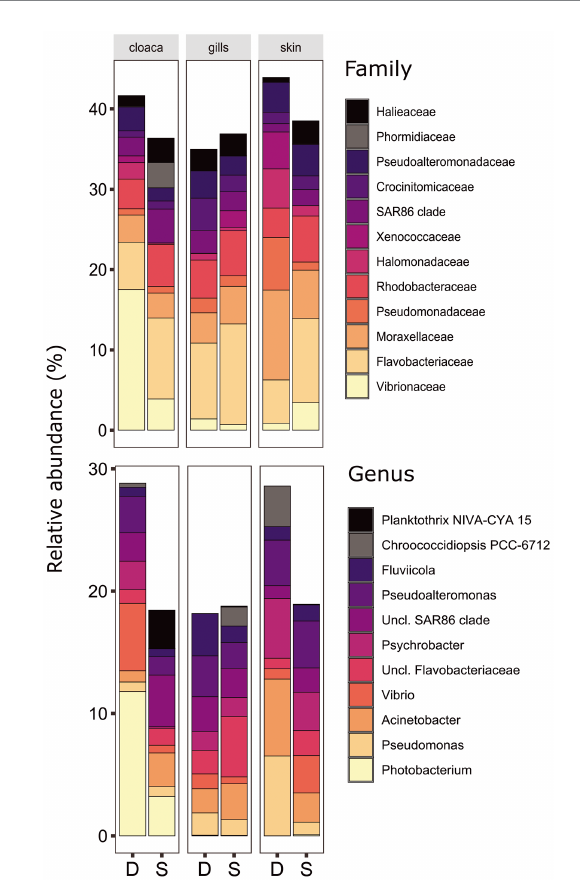
FIGURE 2 Bacterial compositions and relative abundance to Family (top) and Genera (bottom) resolution of dusky (D) and sandbar (S) sharks across three distinct organs. All groups below 3% relative abundance were not included.